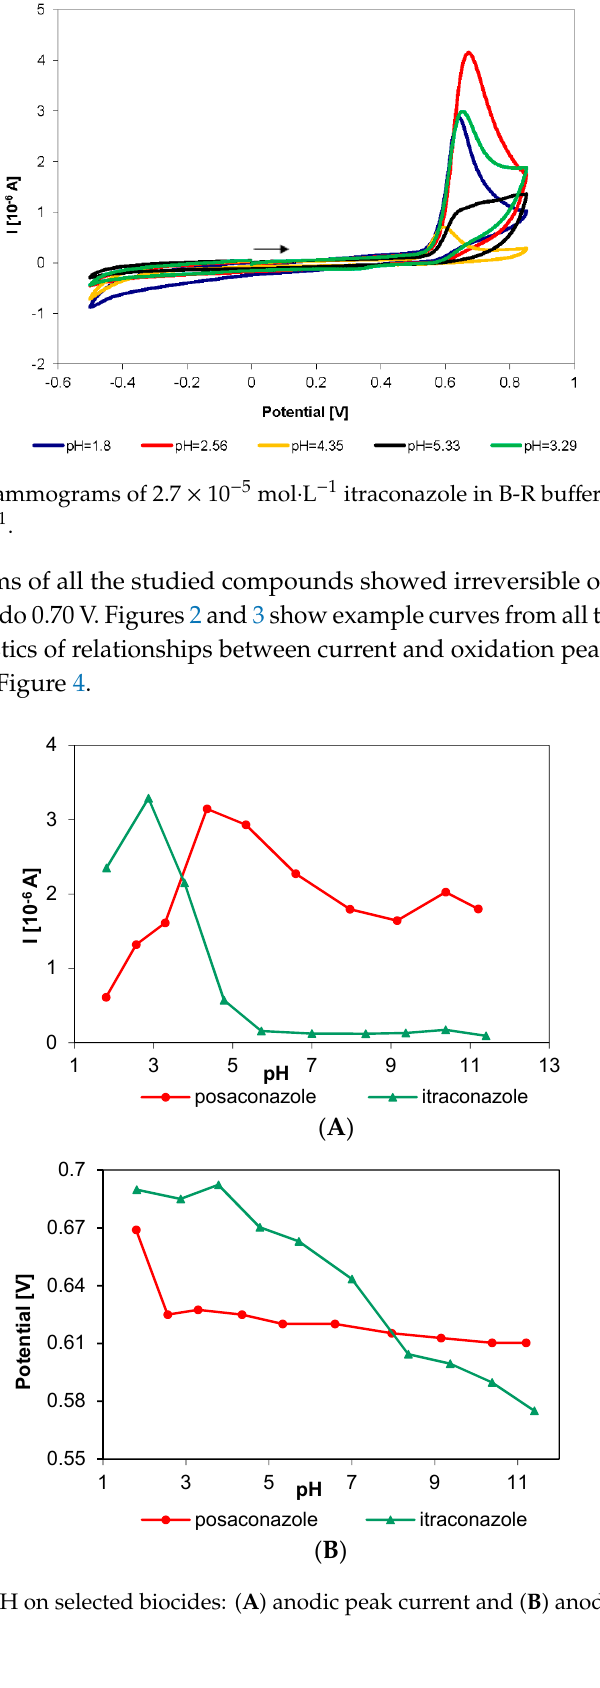
Figure 2. Cyclic voltammograms of 2.7 × 10 − 5 mol·L − 1 posaconazole in Britton-Robinson (B-R) buffer in the pH 1.8–11.2 range; v = 100 mV·s − 1 .